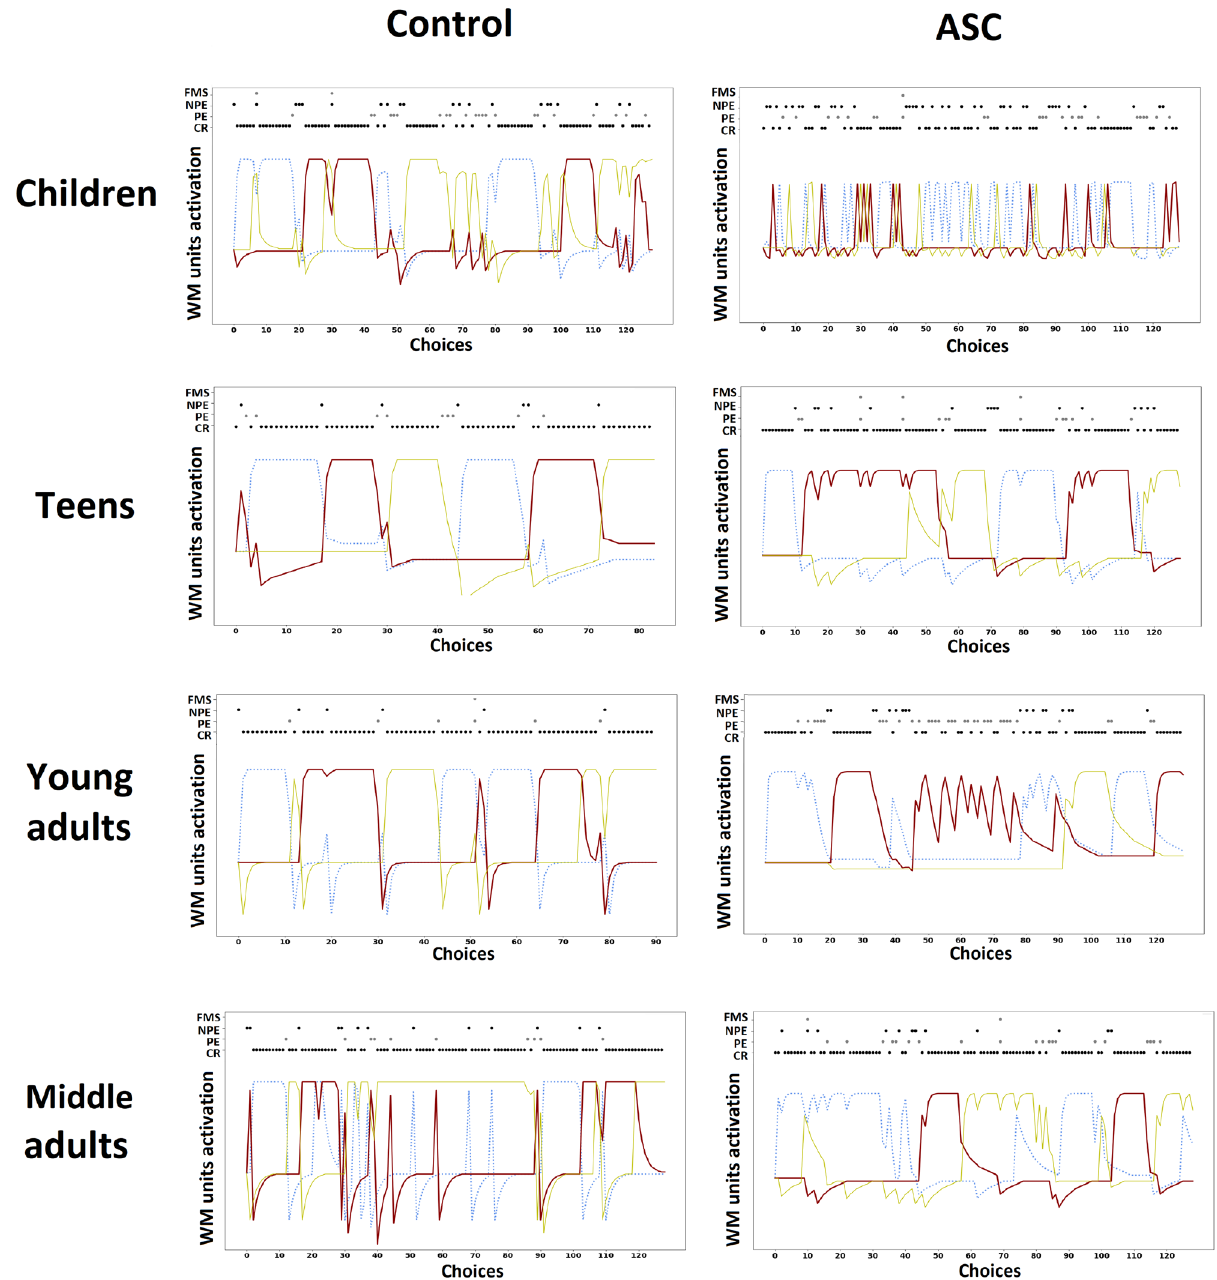
Figure 5. Internal functioning of the executive working memory of the control and ASC models. Each line represents the activation of a memory unit encoding a specific matching rule: thick red line: colour-based matching rule; dotted thin blue line: shape-based matching rule; continuous yellow line: size-based matching rule. The dots at the top of graphs indicate the instances of correct responses (CR) or errors (PE, NPE,